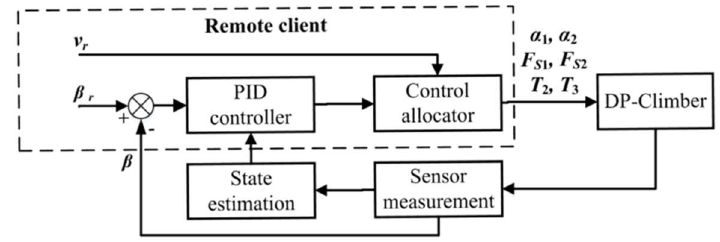
Figure 8. Control system of DP-Climb. Table 2. k p , k i and k d coefficients selected in the process of ground-wall transition. Critical Transition Angle β ( ◦